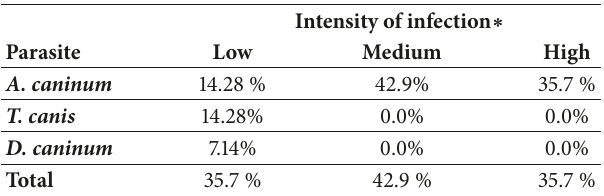
Table 2: Intensity of infection with canine intestinal parasite eggs in pooled samples collected from 14 public parks in the city of